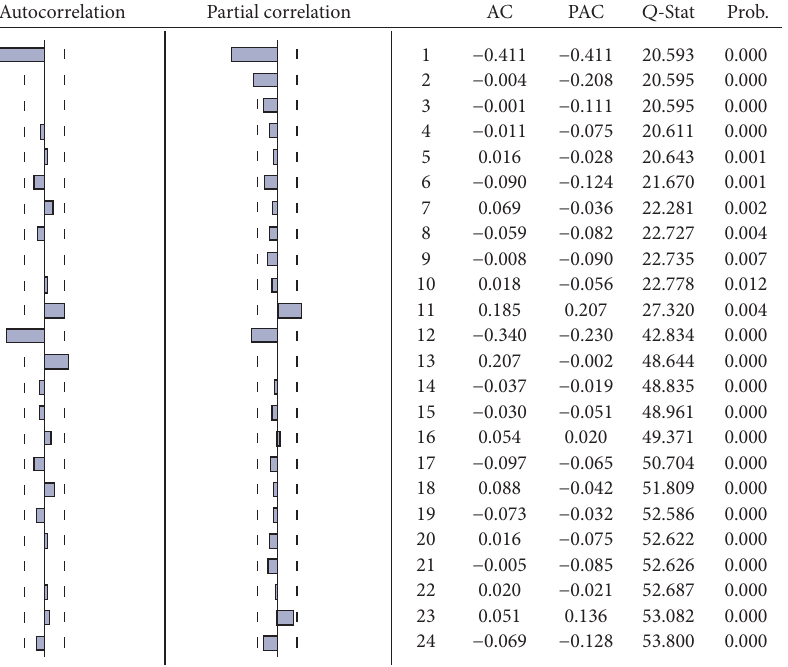
Figure 3: Autocorrelation figure and partial autocorrelation figure.